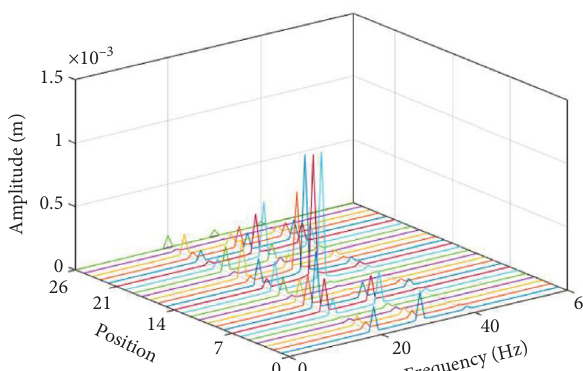
Figure 16: Frequency-domain characteristics of multicylinder